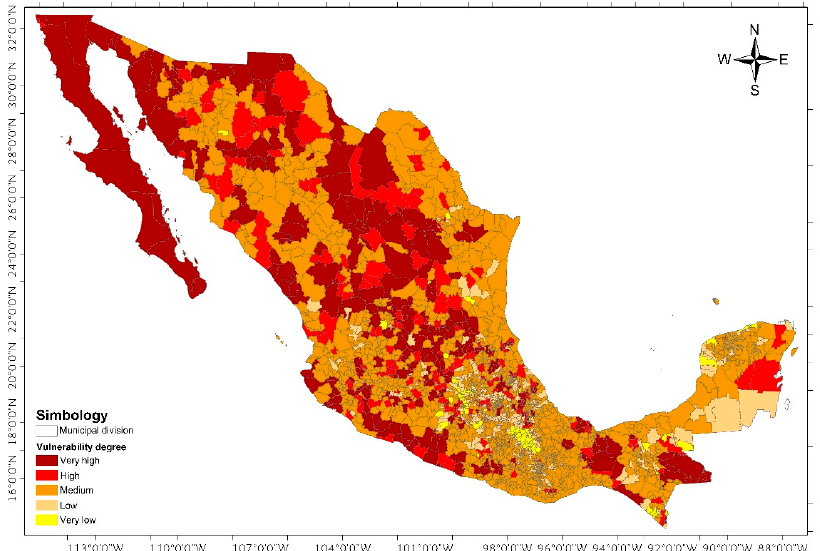
Figure 7. Map of environmental vulnerability to drought.